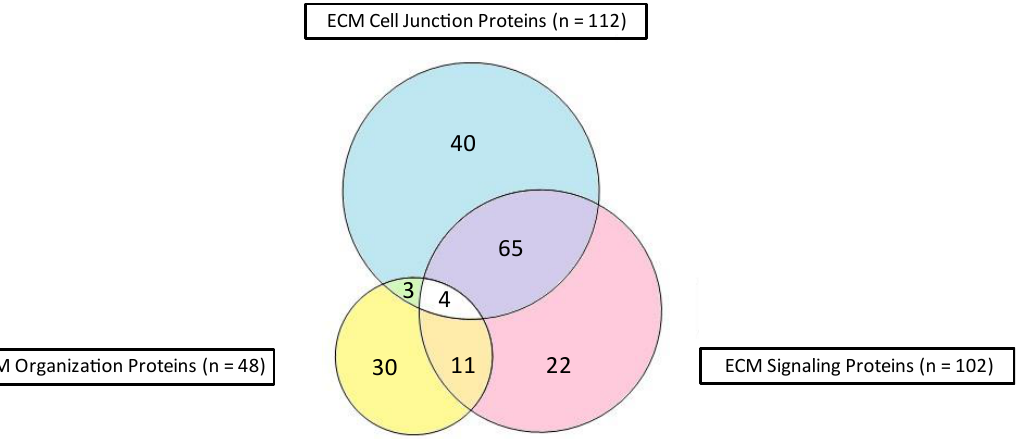
Figure 7. Venn diagram showing the overlap of different functions of the proteins of the matrisome identified in our dataset. Circle sizes are scaled based on the number of proteins and the number of shared proteins between the three groups.